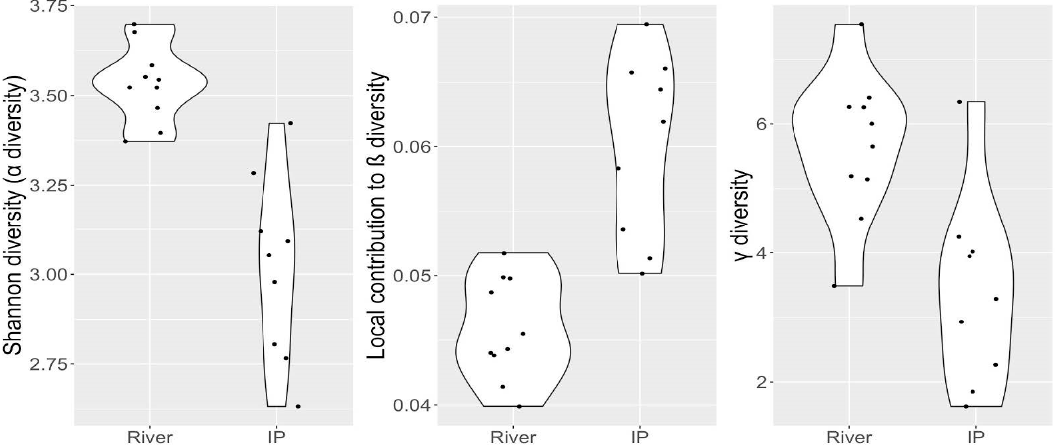
Figure 6. Comparison of alpha (i.e., Shannon diversity), beta (local contribution to beta diversity) and gamma diversity between independent perennial rivers (left) and isolated pools ((right), IPs) from California sampled simultaneously (data from Reference